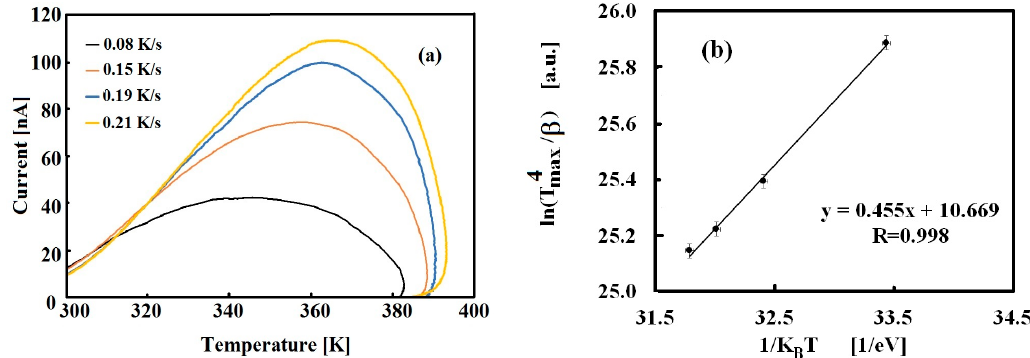
Figure 3. ( a ) Thermally stimulated current (TSC) measured in the 300–400 K range measured with four different heating rates, V b = 5 V, after priming at T = 295 K with a white LED source (same priming conditions). Data are obtained by subtracting the background current measured during cooling from the current measured during the heating stage. ( b ) Linear plot and best-fit used to determine trap energy level and capture cross-section.